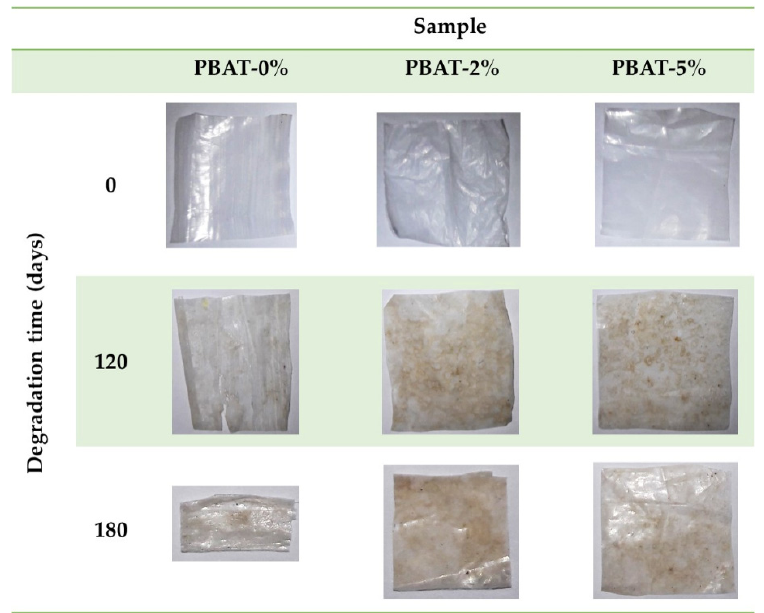
Figure 1. Representative photos of PBAT and nanocomposite film samples, before and after soil burial degradation test.